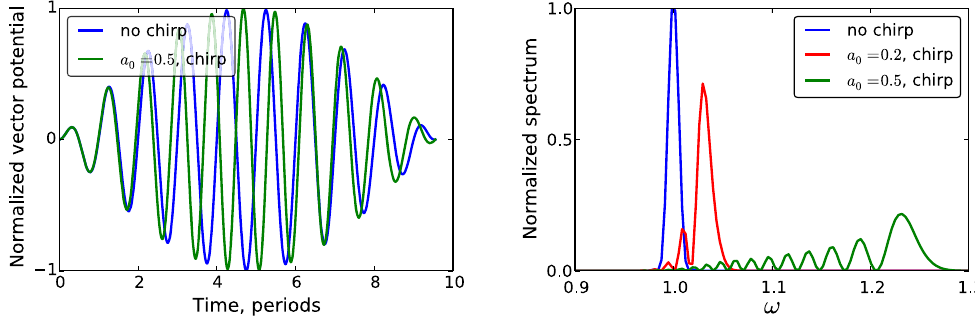
FIG. 5. Left: Normalized vector potential as a function of time in periods for the case of the unchirped laser pulse (blue color) and ¼ 60 . Right: Laser pulse spectra (normalized to the peak value of the chirped laser pulse with a 0 ¼ 0 . 5 for laser pulse with duration τ L unchirped pulse spectrum) for the case of unchirped laser pulse (blue color) and chirped laser pulses with a 0 ¼ 0 . 2 (red color) and ¼ 600 a 0 ¼ 0 . 5 (green color) for laser pulse with duration τ L